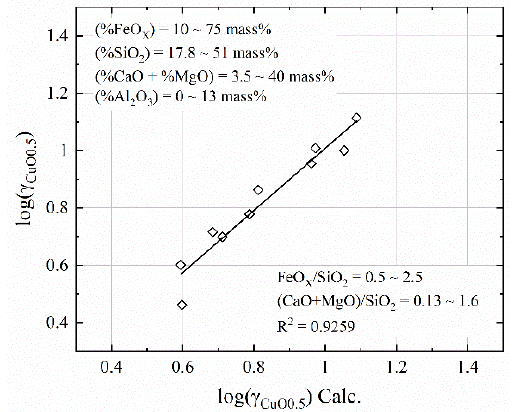
Figure 5. Empirical formula using regression analysis.